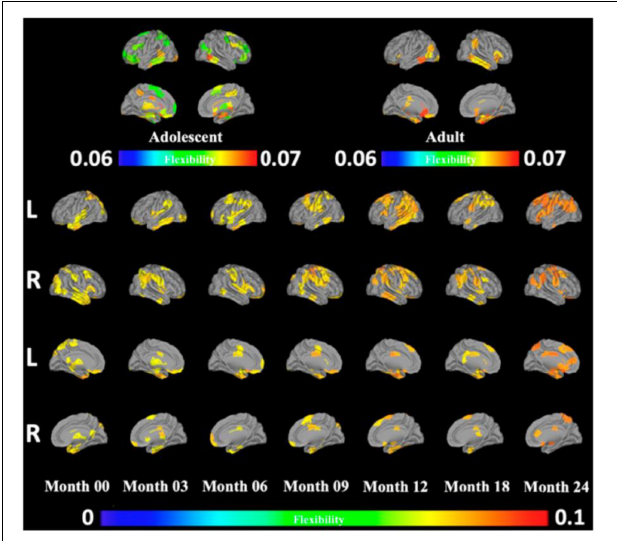
FIGURE 2 | Reprinted with permissions from Yin et al. (2020). The development of the flexible club infancy, in adolescence, and in adulthood. Red indicates regions with significantly higher flexibility than the whole brain, and blue indicates regions with significantly lower flexibility than the whole brain. Orange indicates regions with no significant difference in flexibility from the whole